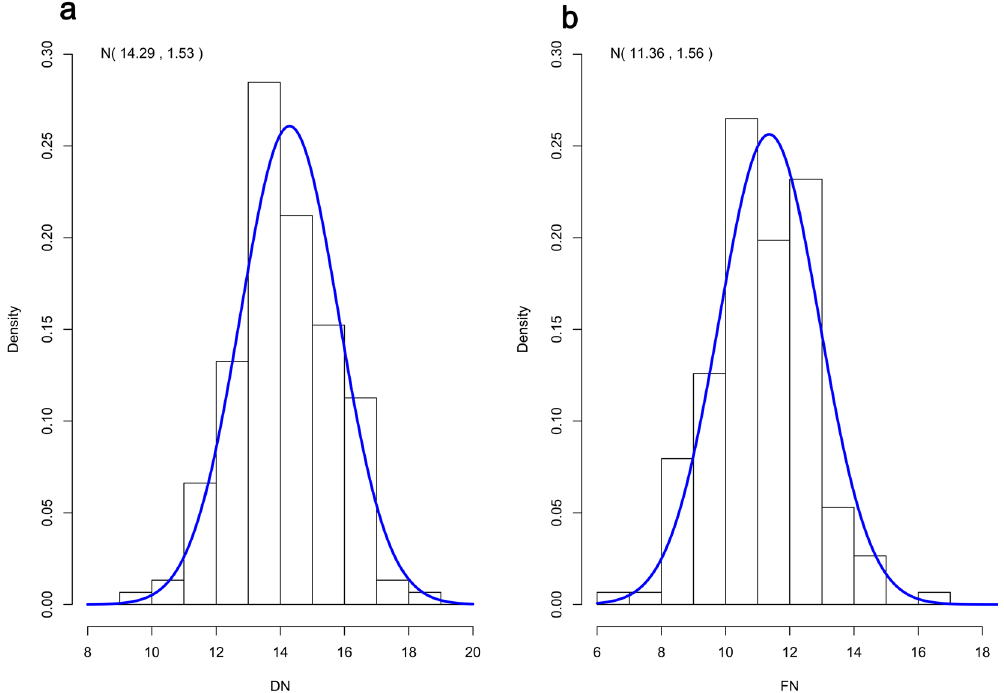
Figure 1. Duration of fertility trait in hens. ( a , b ) Histogram illustrates the distribution of DF trait within the population of egg-laying hens (n = 304). DN: the days post-insemination until the last fertile and FN: the numbers of fertile eggs laid after artificial insemination (AI). Bell-shaped indicate the normal distribution and the density curve was determined by standard normal distribution parameters N ( µ , σ ) where µ is the mean and σ is the standard